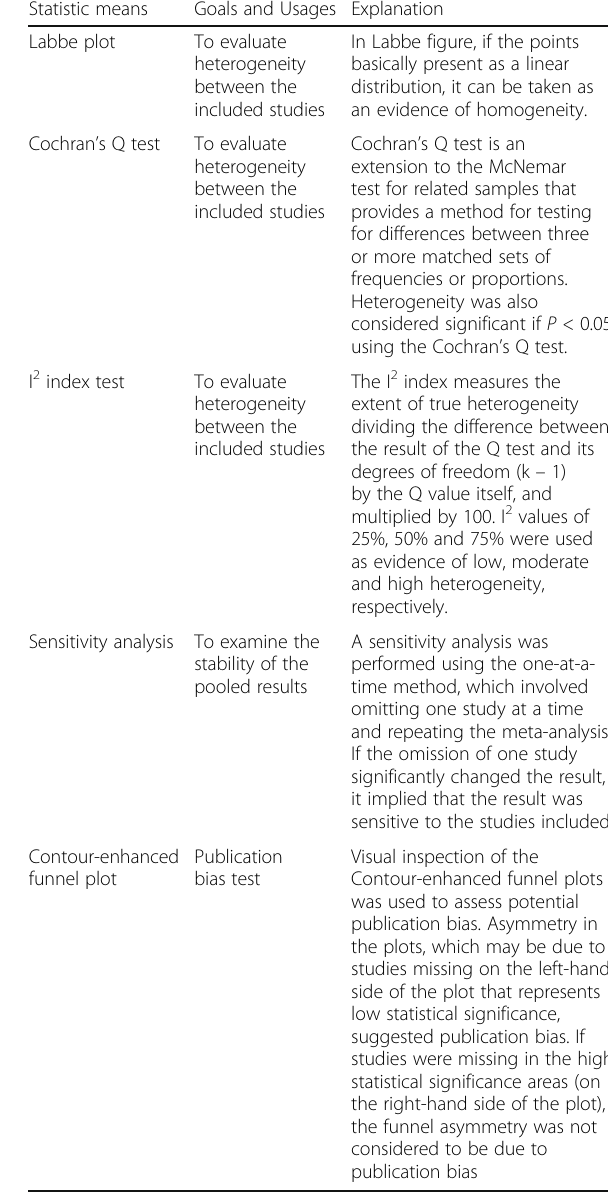
Table 4 The statistical methods used in this meta-analysis